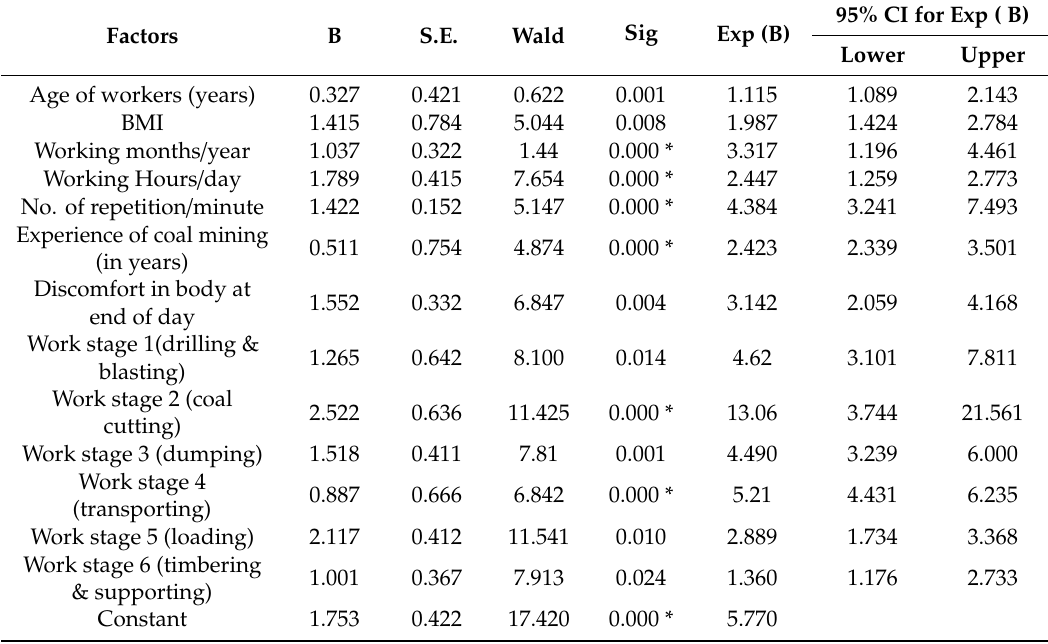
Table A2. Estimation of regression coe ffi cients with their confidence interval for lower back